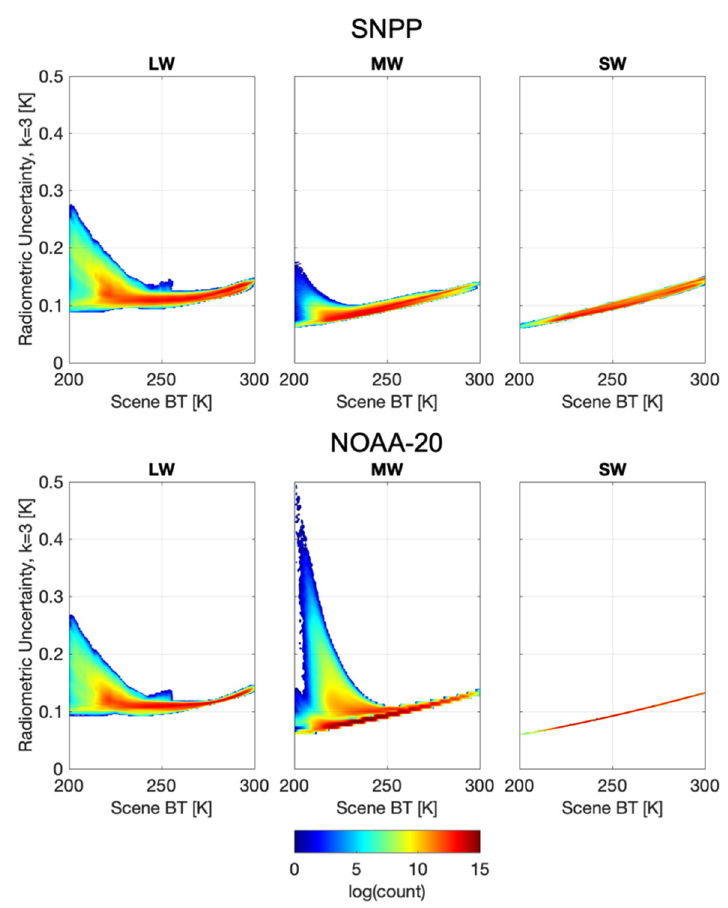
Figure 1. Radiometric uncertainty (RU) for one orbit of data from the SNPP (top) and NOAA-20 (bottom) Cross-track Infrared Sounder (CrIS) consistent with the methodology and uncertainty contributors originally described by Tobin et al. [7] for SNPP. Two distributions are evident in the NOAA-20 midwave (MW) RU, one with larger RU (associated with MW FOV 9), and one that is quite similar in shape and magnitude to the SNPP MW RU distribution. Polarization was not expected to be a significant contributor to radiometric uncertainty and was not included in the original SNPP RU assessment and has not been included in these results for consistency with the original SNPP analysis. Updated radiometric uncertainty estimates including the contribution associated with the uncertainty in polarization correction are provided in Section 5.